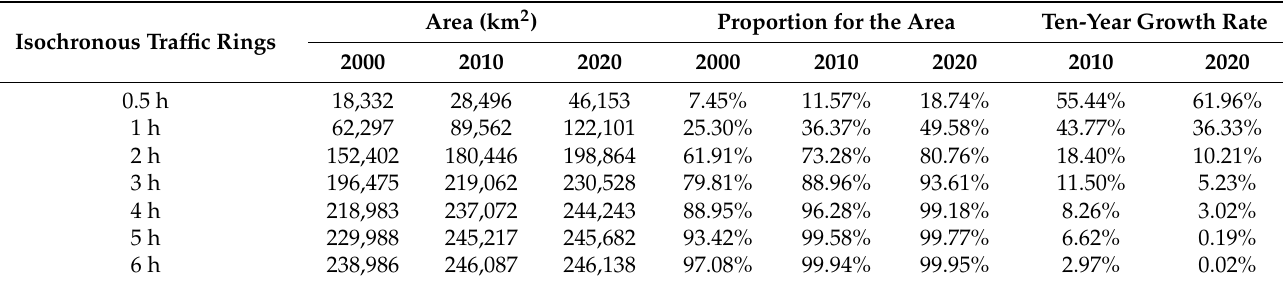
Table 3. Land areas for isochronous rings.